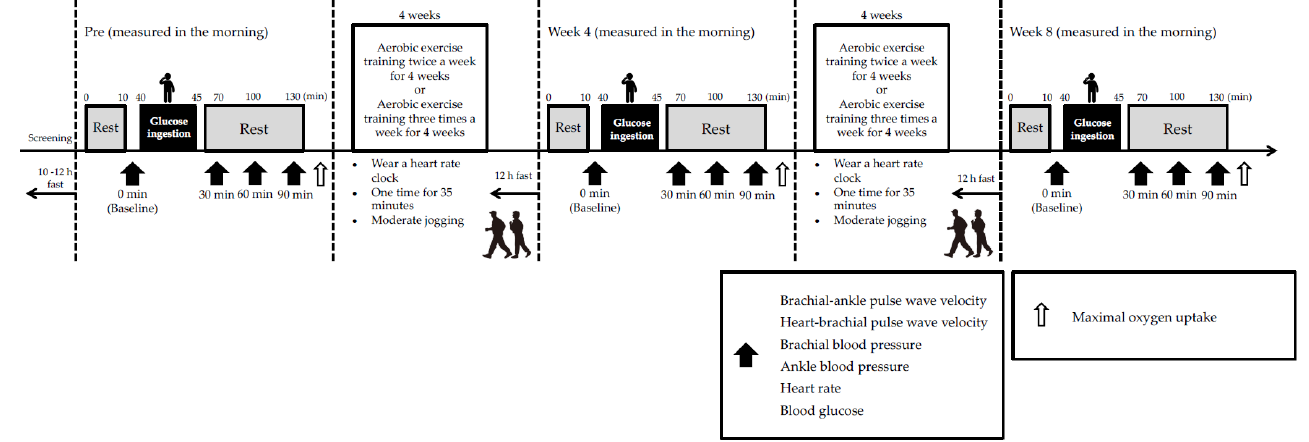
Figure 1. Study design. Arterial stiffness, blood pressure, heart rate, and blood glucose levels were measured baseline, 30, 60 and 90 min after the 75-g oral glucose tolerance test after 10 min of supine rest before, 4 and 8 weeks after the aerobic exercise training intervention. Thereafter, maximal oxygen uptake was measured using a bicycle ergometer.